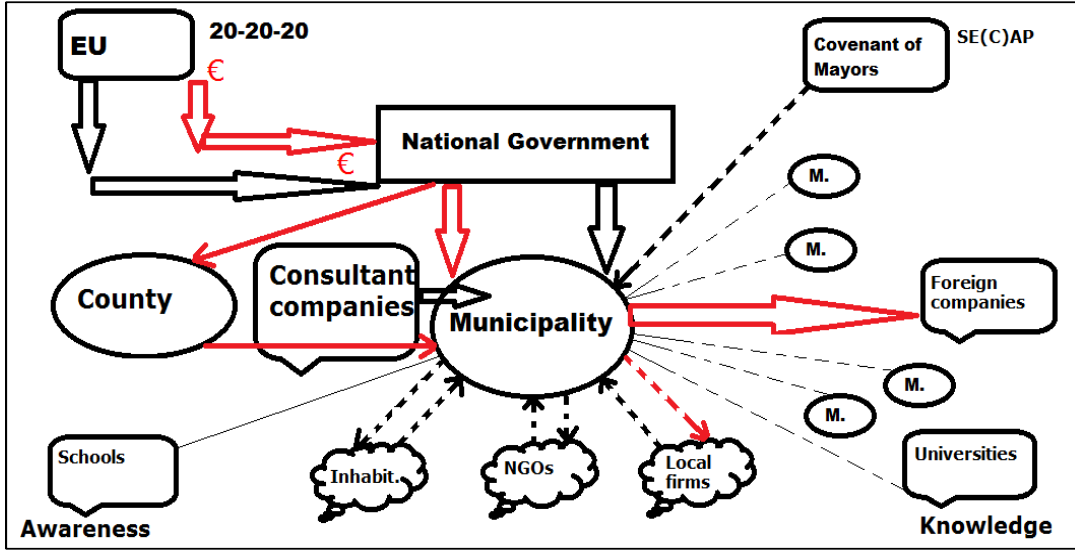
Figure 10. The system of RES and climate governance from a municipal point of view (authors’ edition).